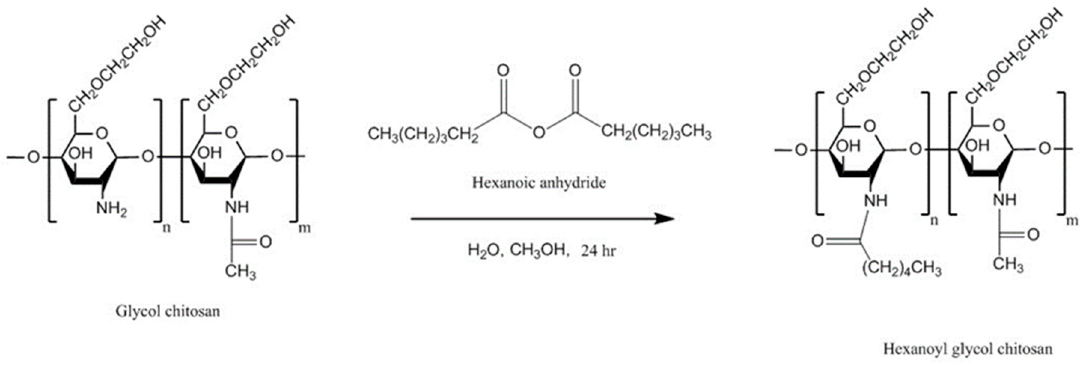
Figure 14. Synthetic pathway to hexanoyl glycol chitosan [131].